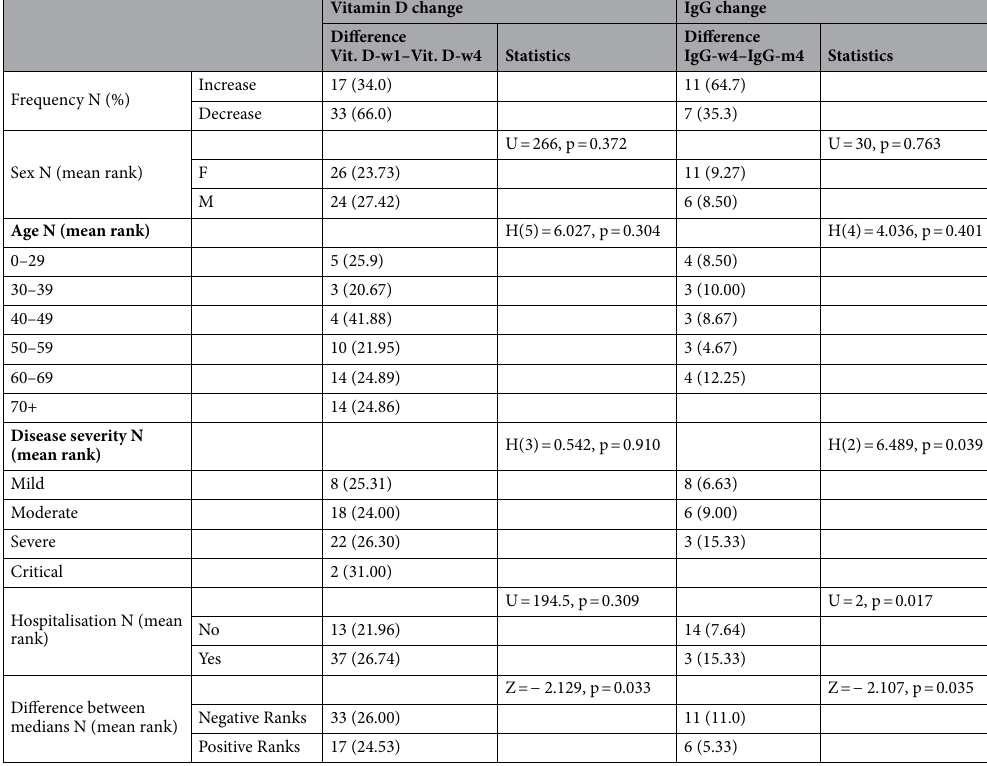
Table 3. Vit. D level change (difference Vit. D‑w1–Vit. D‑w4) during illness and IgG level change 3 months PSO (difference IgG‑w4–IgG‑m4). U Mann–Whitney U test, H Kruskal–Wallis test, Z Wilcoxon Signed Ranks